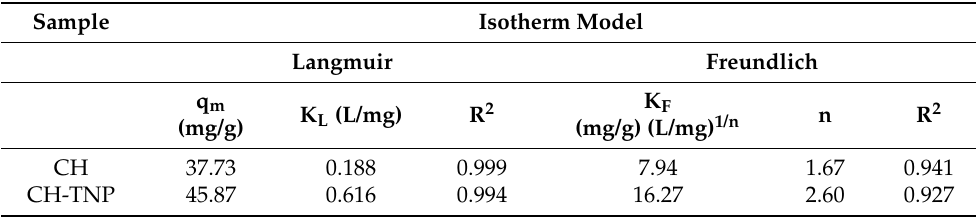
Table 2. Isotherm modeling parameters for Cu(II) adsorption.